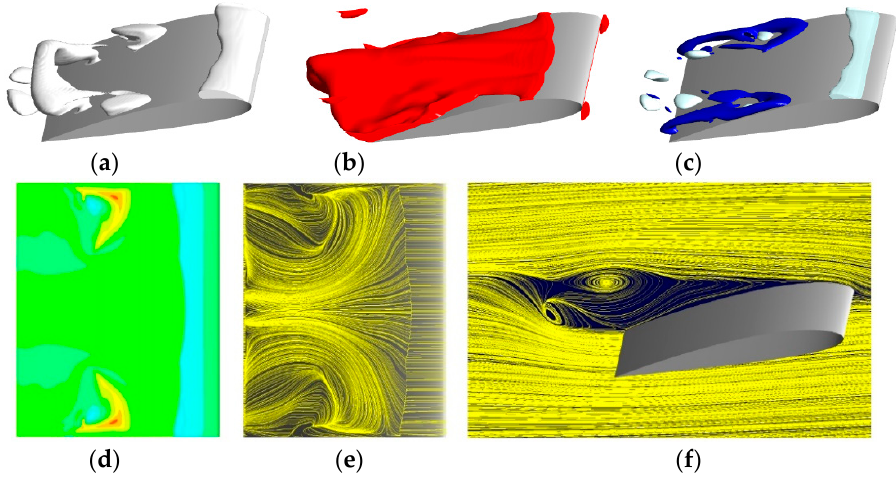
Figure 22. Time instant 2. ( a ) 3D view of cavitation regions (in white); ( b ) back-flow regions (in red); ( c ) evaporation regions (in light cyan) and condensation regions (in dark blue); ( d ) temperature dif- ferences on hydrofoil suction side; ( e ) vector lines on hydrofoil suction side; ( f ) vector lines in sym- metry plane.